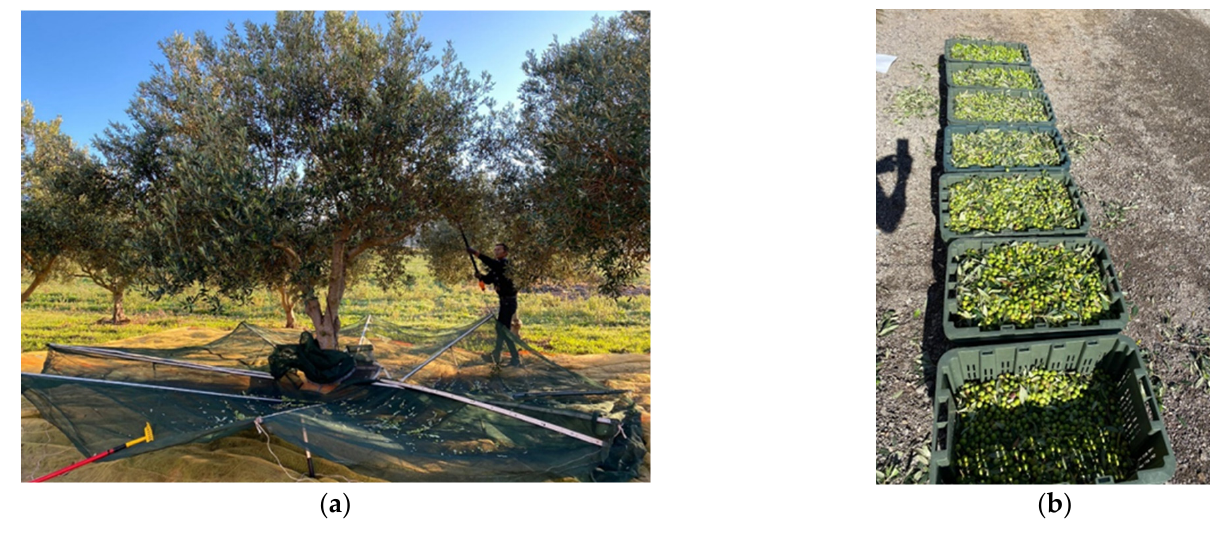
Figure 5. Field use of the Pellenc Olivion P230 shaker ( a ). Harvested olives ( b ).